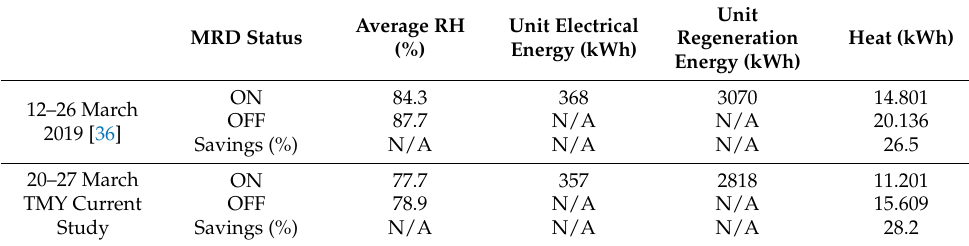
Table 10. Comparison between experimental data and simulation results for LDD spring test case. MRD